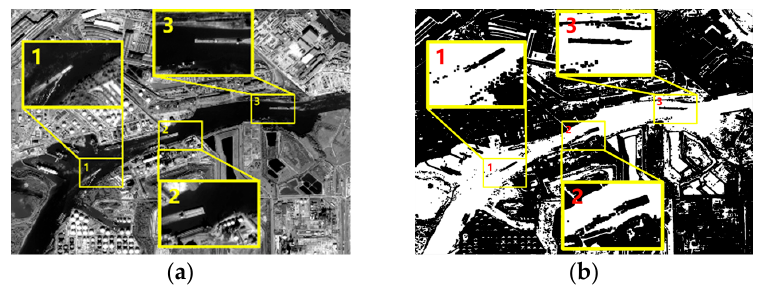
Figure 9. The result of background extraction: ( a ) Original Data; ( b ) Otsu’s method result.